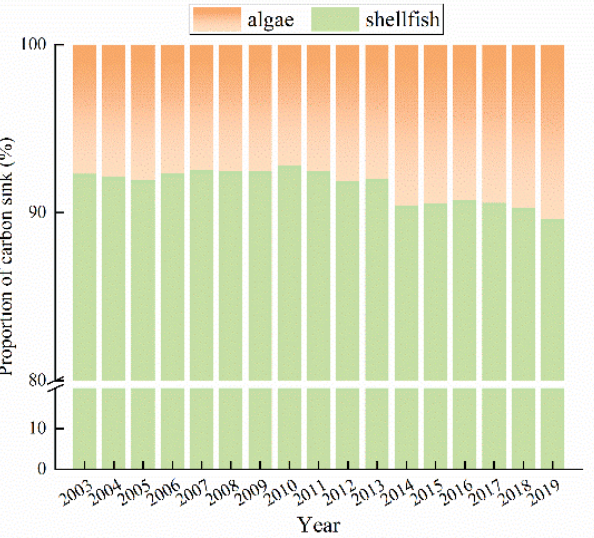
Figure 4. Proportion contributions to the fisheries carbon sink by shellfish and algae in China from 2003 to 2019.